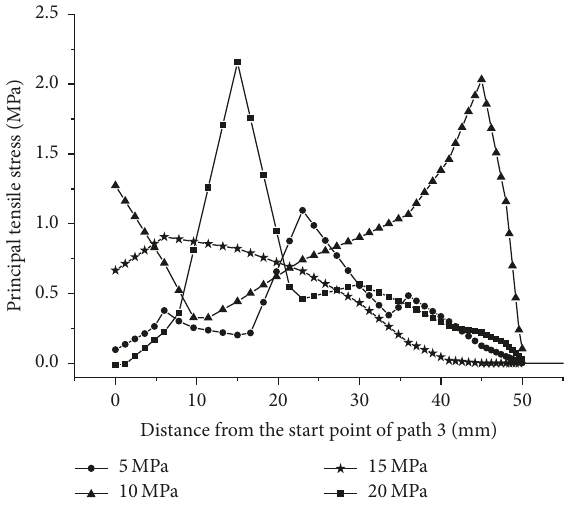
Figure 27: Comparison of the principal tensile stress generated along path 3 from corrosion-induced expansion when the displacement resulting from corrosion-induced expansion reaches 0.022 mm.